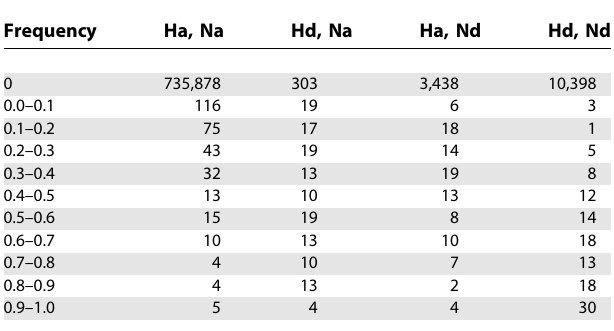
Table 2. Summary of Data Analyzed from Green et al. [2] Table 3. Summary of Data Analyzed from Noonan et al.